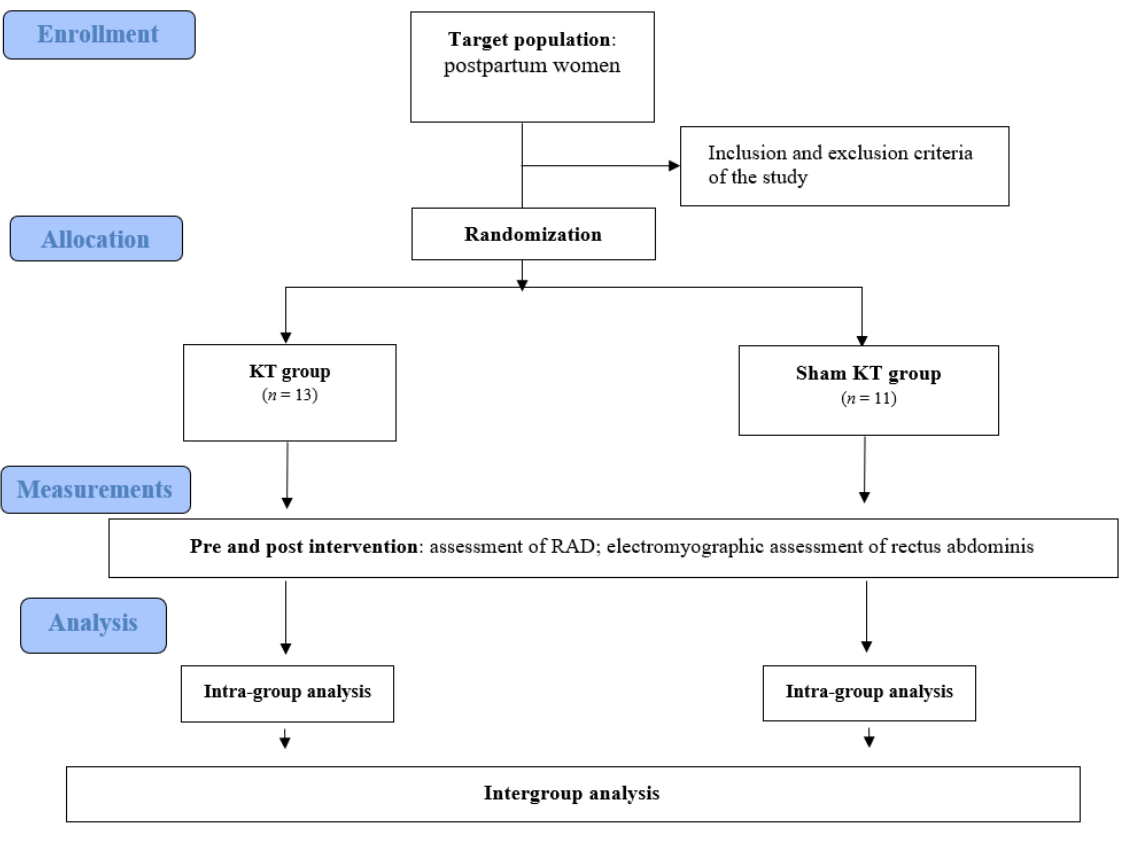
Figure 3. The flow of the participants at each stage of the project.